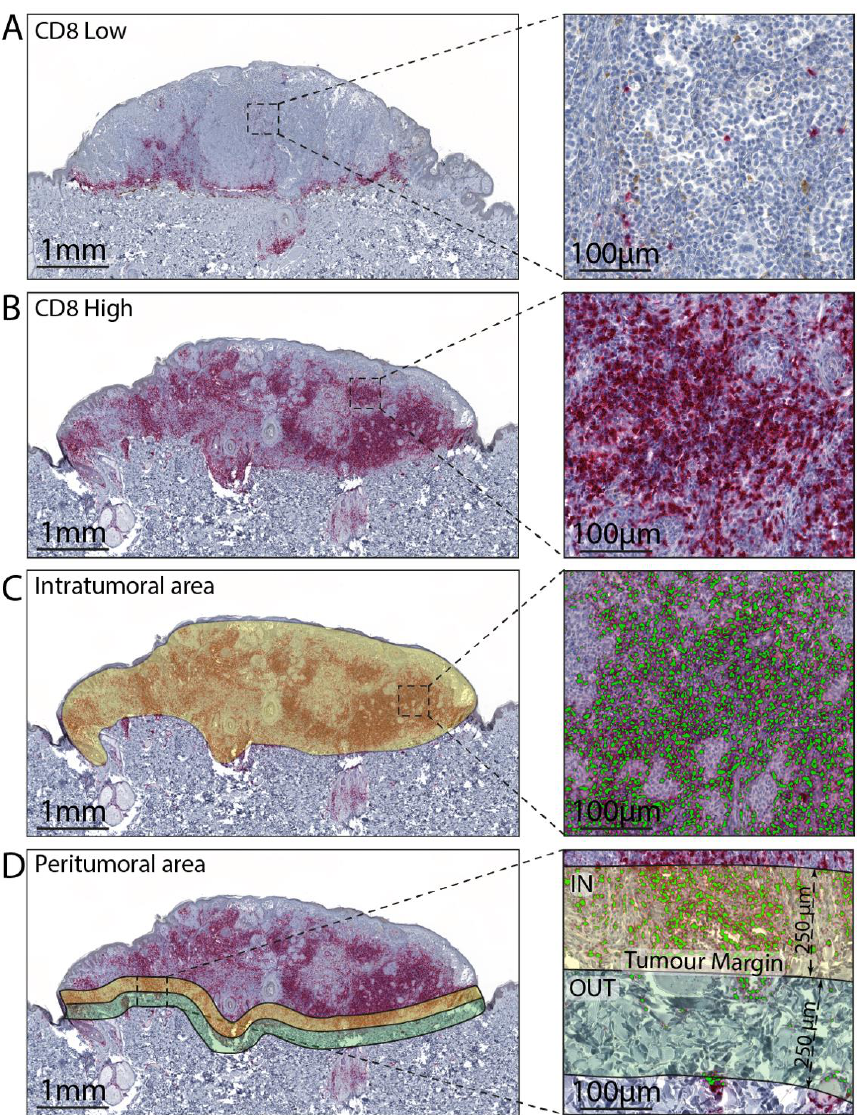
Figure 1. Representative images of melanoma tissue with low ( A ) and high ( B ) CD8 positive cells. ( C ) Representative annotation mask for intratumoral area and CD8 cells software recognition. ( D ) Representative annotation mask for inner (yellow, IN) and outer (green, OUT) portion of the peritumoral area and CD8 cells software recognition.